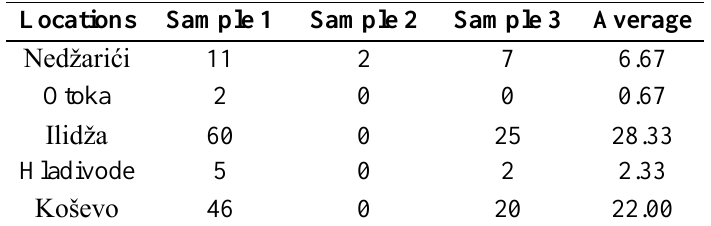
Table 1. CFU from all